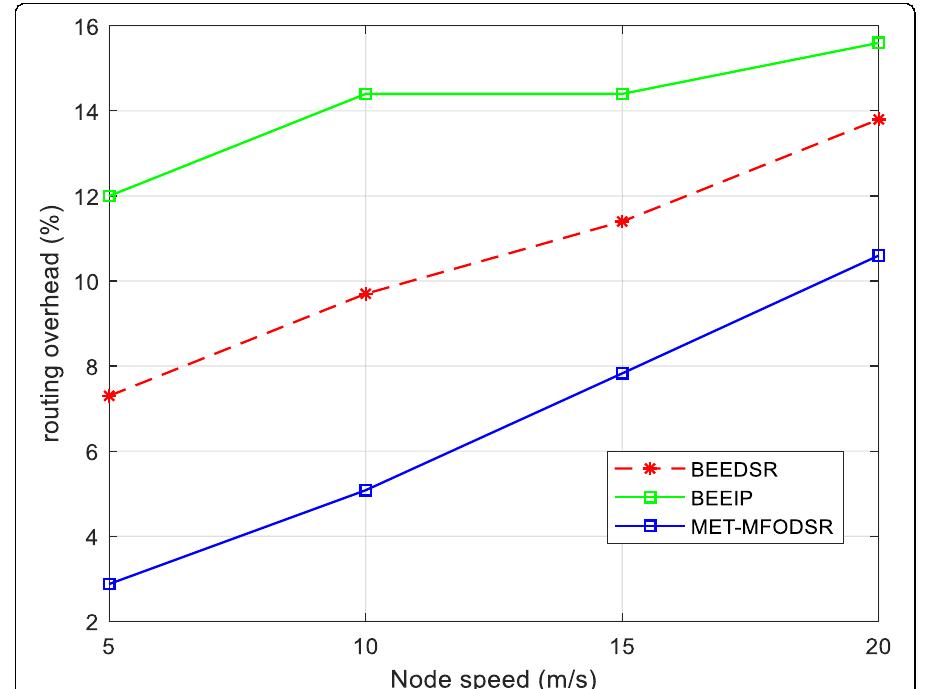
Fig. 12 Routing overhead simulation results for BEEDSR, BeeIP, and MET-MFODSR. The simulation results of the routing overhead under the node speed variation